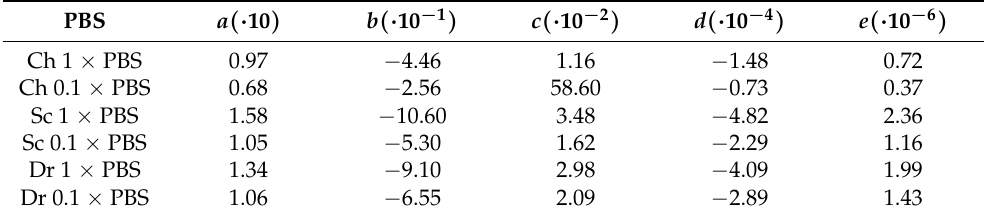
Figure A2. Device sensitivity as a function of the activation percentage calculated for twelve random- ized activated receptors configurations corresponding to the same ( a ) channel-centered, ( b ) source- shifted or ( c ) drain-shifted distribution. Markers account for simulated data, while shaded areas depict σ S and lines correspond to (cid:104) S (cid:105) . Both 1 × PBS (blue) and 0.1 × PBS (red) concentrations were simulated. Results obtained for the uniform distribution are depicted by dashed lines. Table A2. Parameters of the fitting curves ζ = a + bP + cP 2 + dP 3 + eP 4 from Figure